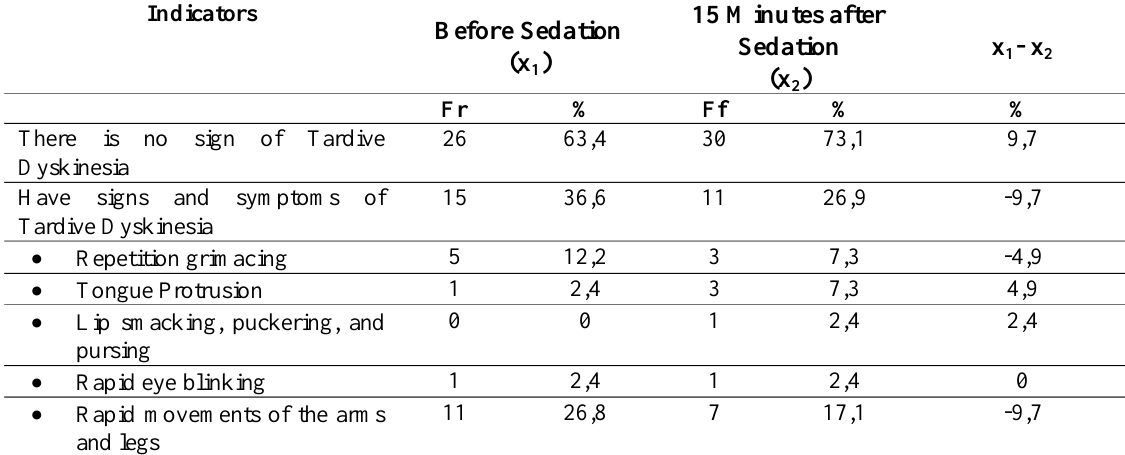
Table 4. Tardive Dyskinesia in Critical patients at Intensive Care Installation (n=41)*